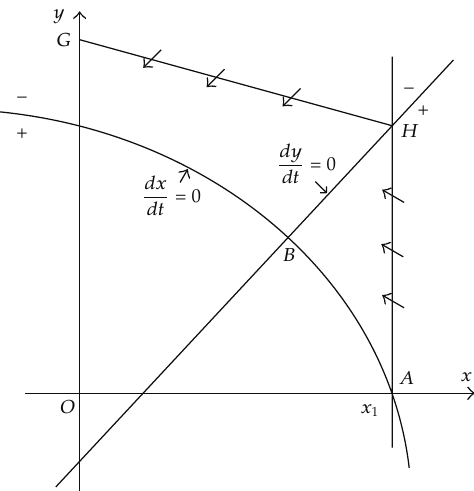
Figure 1: The uniformly bounded